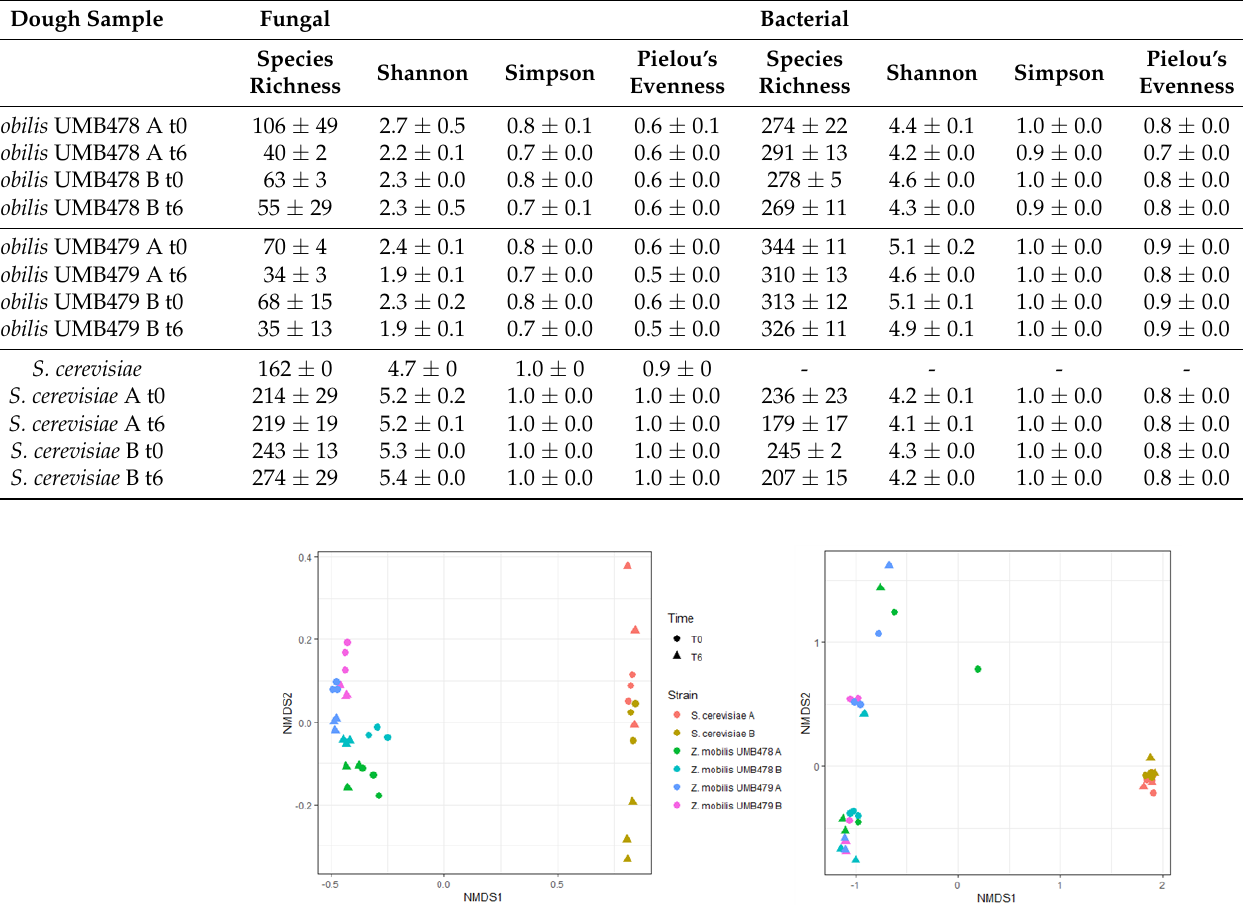
Table 6. Species richness, diversity indices (Shannon and Simpson) and Pielou’s evenness of the bacterial and fungal communities of doughs at time 0 and after 6 h of leavening with Z. mobilis UMB478, UMB479 and S. cerevisiae . Data are indicated for both technological replicates (A and B).